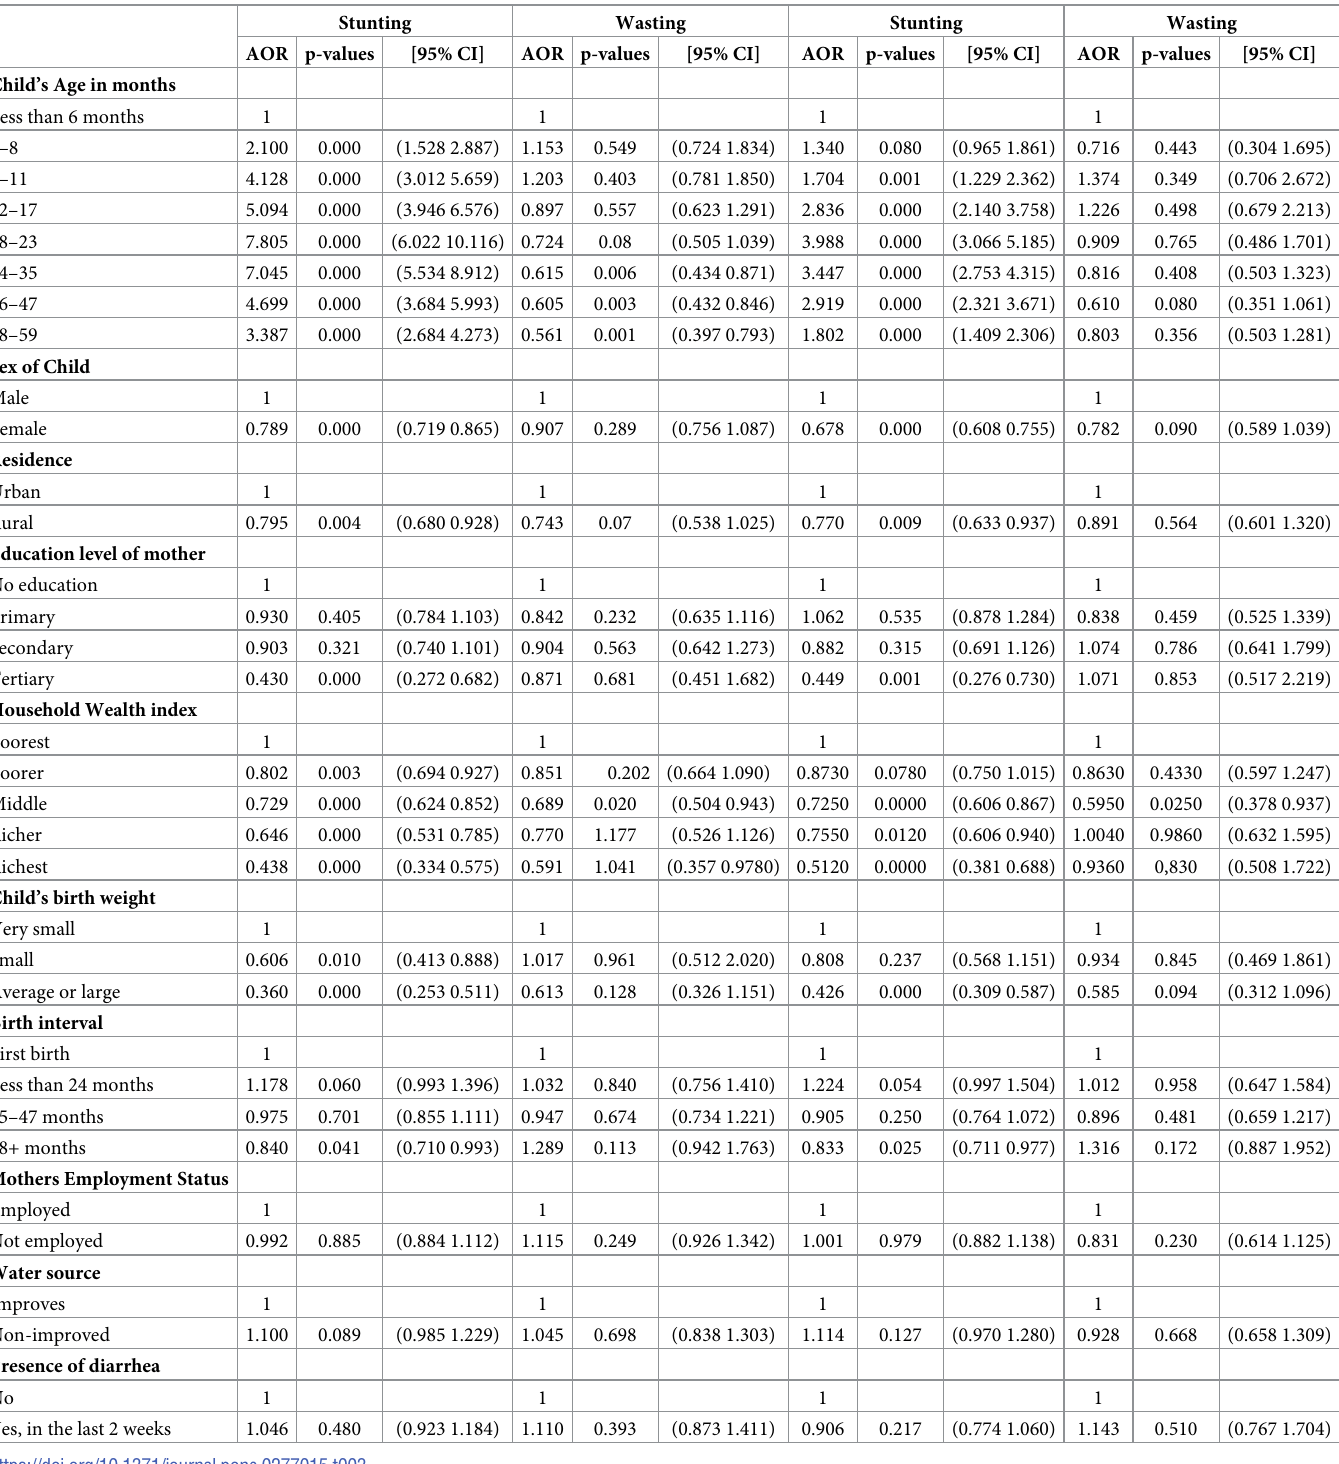
Table 3. Multivariate analysis of malnutrition indicators (stunting and wasting) for 2013/14 and 2018 DHS waves. Stunting Wasting Stunting